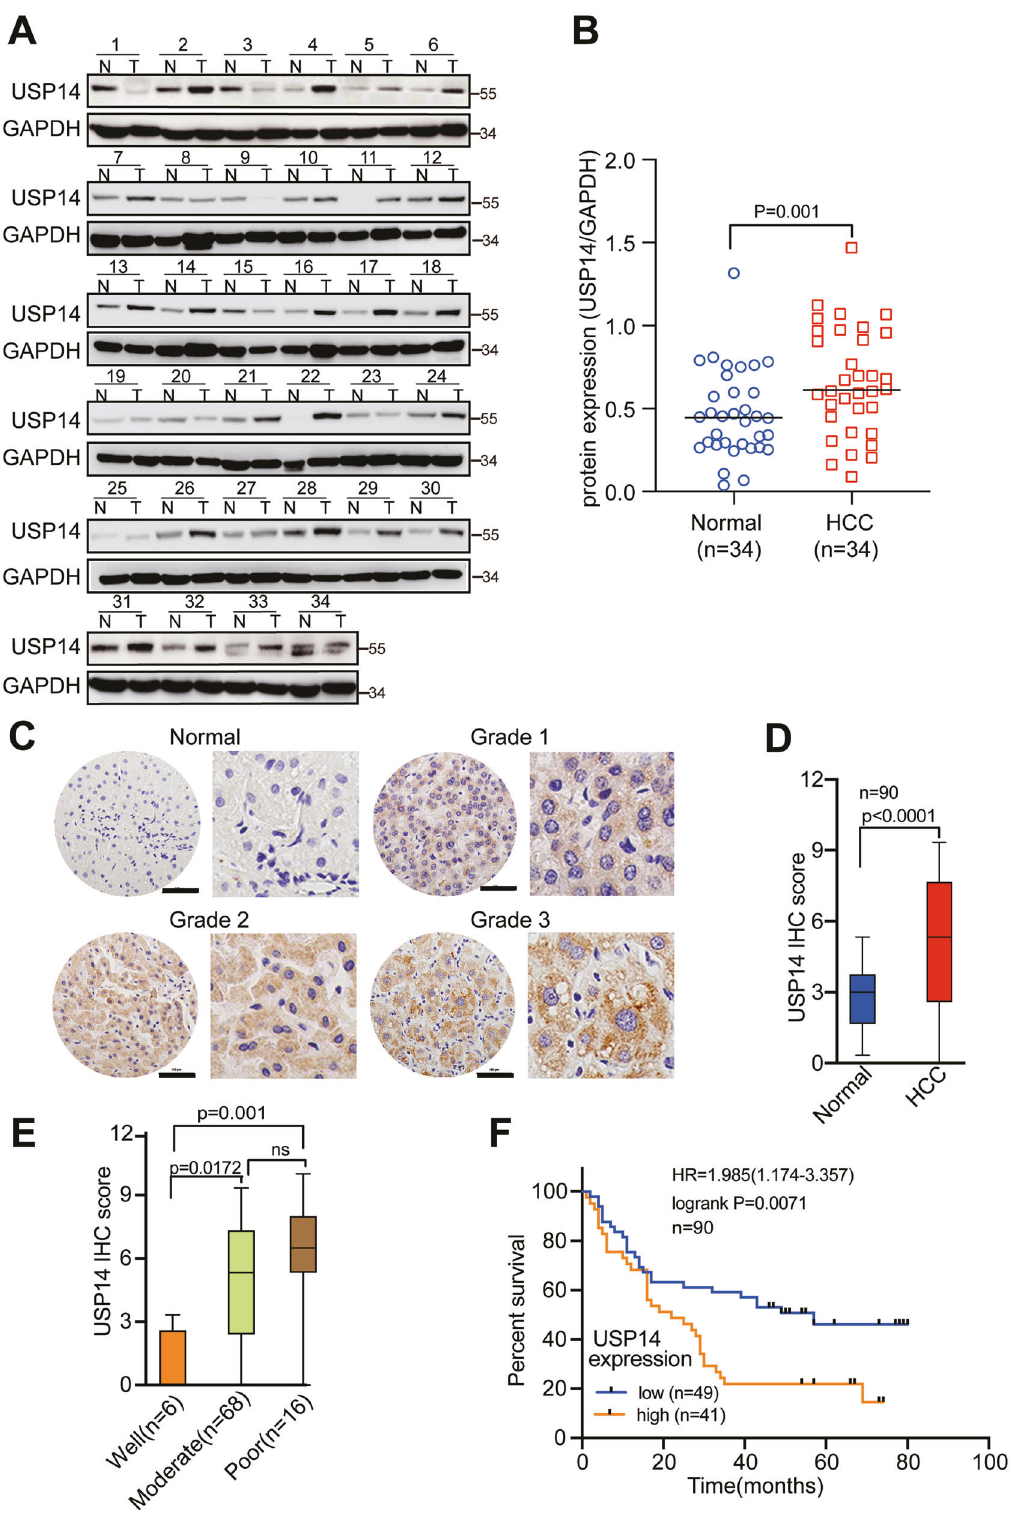
Fig. 1 Upregulation of USP14 predicts poor clinical outcome in patients with HCC. A The protein expression of USP14 in HCC tissues were examined by western blot. N stands for the adjacent non-tumorous tissues, T stands for HCC tissues. B The representative images and the statistical analysis were indicated. C , D The expression of USP14 in adjacent non-tumorous tissues, HCC tissues with different levels of differentiation was detected by IHC. Scale bar, 100 μ M. E The representative images and the IHC scores were shown. F The clinical signi fi cance of USP14 expression in overall survival was evaluated in the TMA-based cohort by Kaplan – Meier survival analyses.